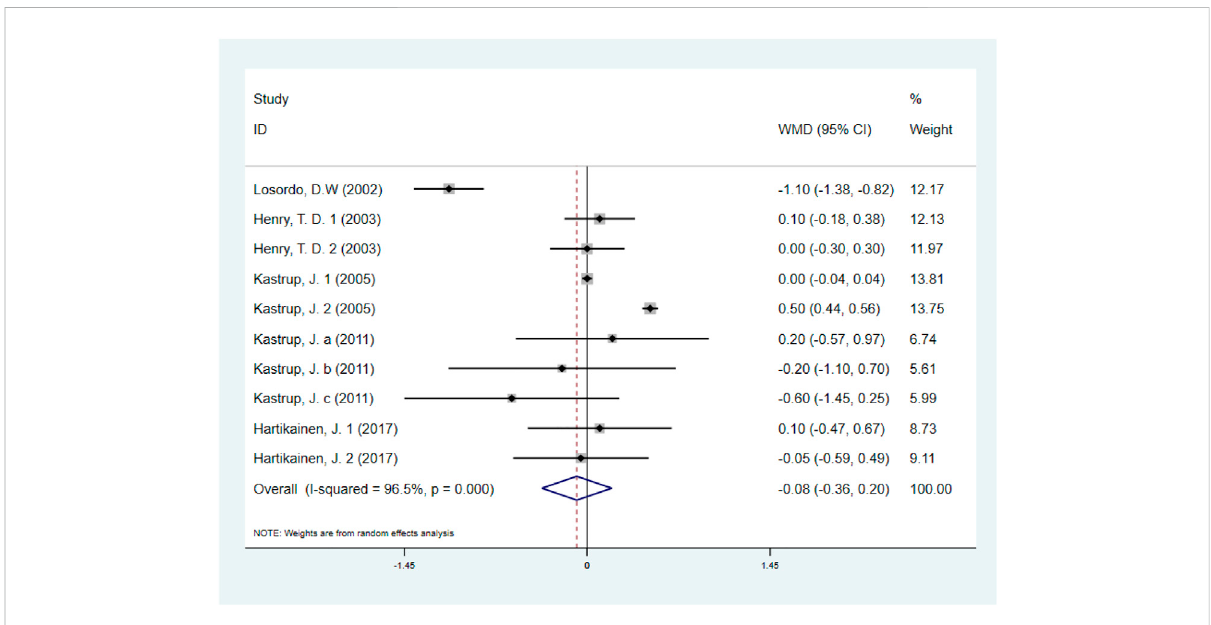
FIGURE 8 Forest plot for CCS angina class, GF vs. control. CCS, Canadian Cardiovascular Society; RR, relative risk; CI, con fi dence interval; ID, identi fi cation.